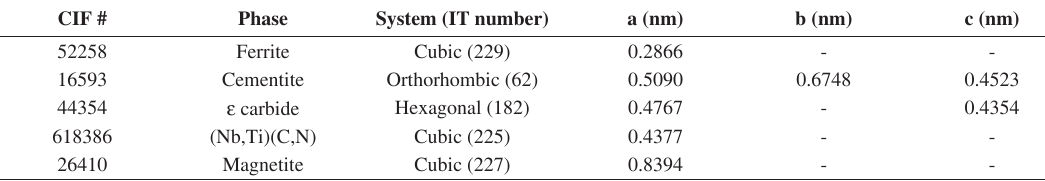
Table 2. Crystallographic parameters of the investigated phases 10